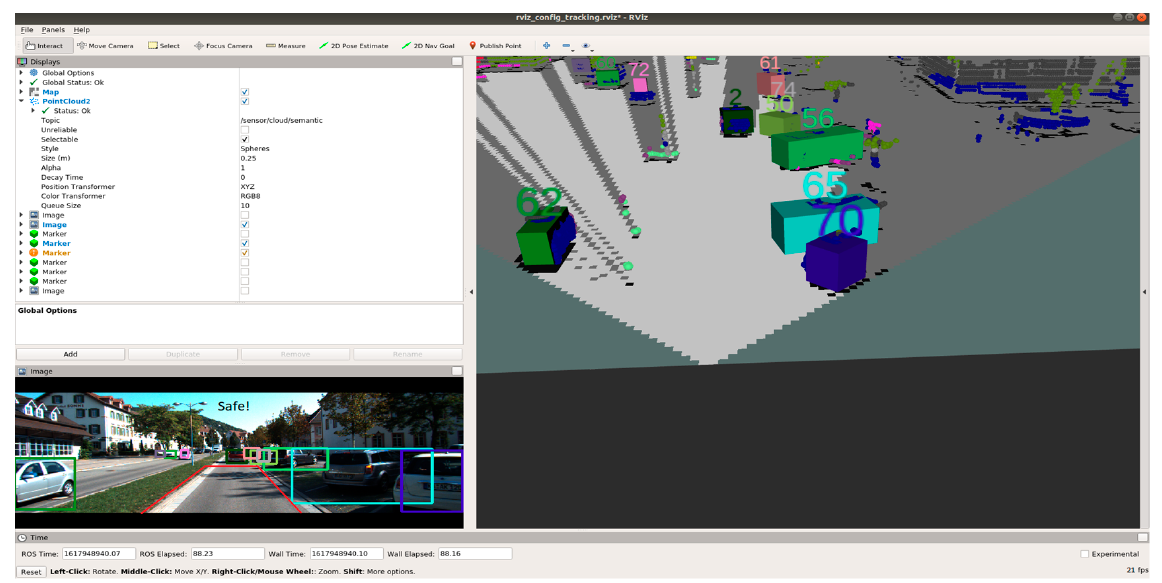
Figure 25. Safe scenario as detected by ODSF-driven EBA (object IDs are depicted above the 3D bounding boxes).